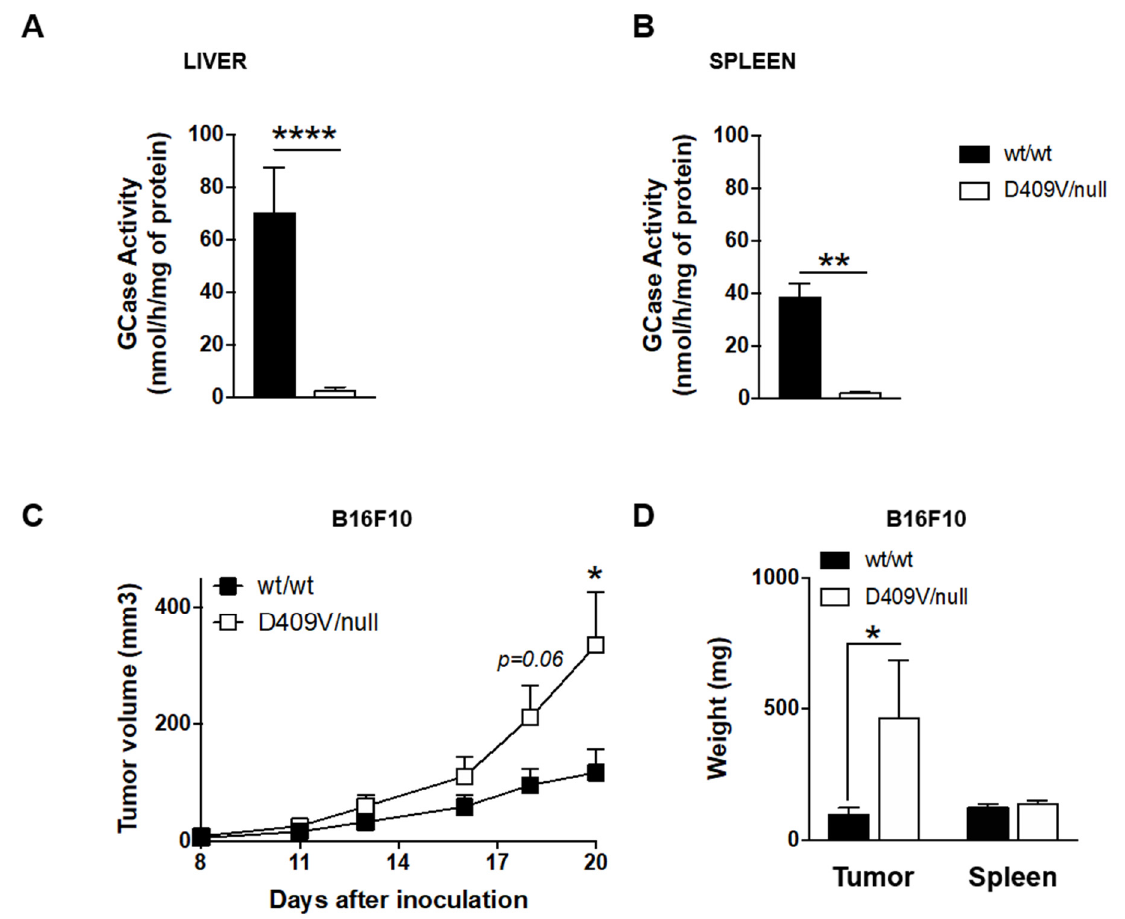
Figure 2. Melanoma tumor growth is increased in Gba1 D409V/null mice. ( A , B ) GCase enzyme activity was assessed in lysates of liver ( A ) and spleen ( B ) isolated from D409V/null mice (D409V/null) or homozygous wild-type littermates ( wt/wt ) having the same mixed genetic background. Assays were performed in duplicate on samples of three to six animals (18–22 weeks of age). ( C , D ) 3 × 10 5 B16F10 melanoma cells were injected subcutaneously into wt/wt or D409V/null mice (19–22 weeks of age). Tumor volumes were measured every 3 days ( C ). Tumor and spleen weights were measured 25 days after tumor inoculation. Data are expressed as means ± SEM of at least two independent experiments ( n = 7–21 mice). Statistical differences were determined using the Mann–Whitney test. Asterisks indicate statistically significant differences: *, p < 0.05; **, p < 0.01; ****, p < 0.0001.